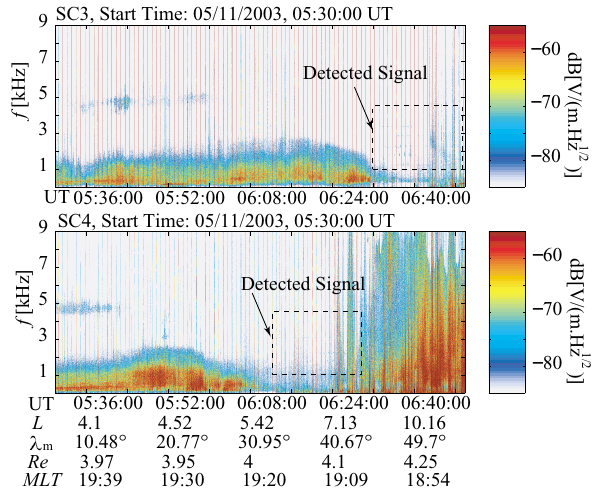
Fig. 8. Detailed WBD spectrogram from the Cluster satellite pass during 26 January 2003, at the time of detection (13:23:45 UT), of the HAARP signal. The magnitude scale refers to electric field intensity. Highlighted are the detected pulses and the separation be- tween the two sideband waves in the detailed zoom-in. Information about the location of the spacecraft, the L shell, Magnetic Local Time (MLT) the radial distance to the Earth (Re) and magnetic lati- tude ( λ m ) is shown below.